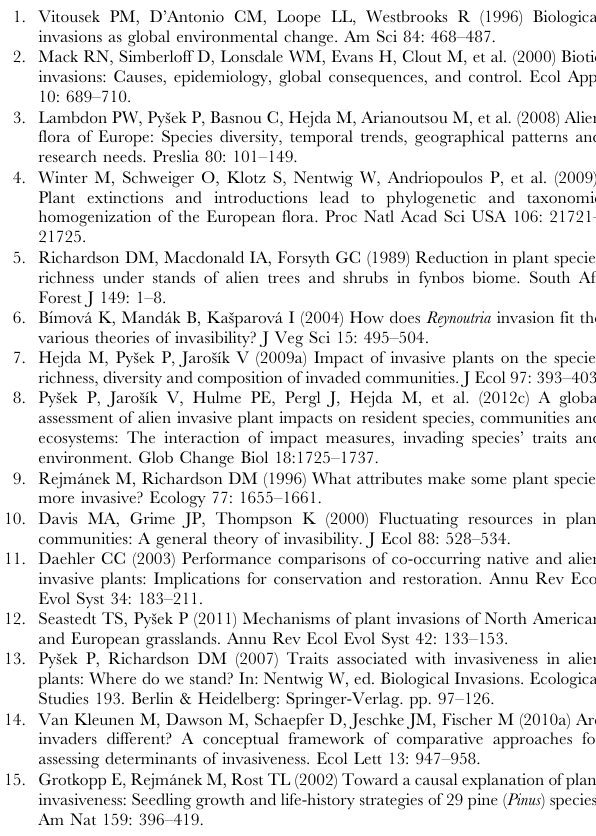
significant. In case of significant interactions between the treatments, the pattern of bars differs for each level of each treatment. Bars of mean species values whose 95% least square differences (LSD) intervals do not overlap are significantly different. In case of a parallel slope of the covariate on all species the patterns are visualised with bars of mean species values expressed for the intercepts of the slopes of the covariate with x- axis; these intercepts correspond to log one of particular biomasses. In case the slopes of the covariate for each species varied significantly, the patterns are visualised as scatterplots of the response variable on the covariate, with a different slope for each species. The panel in (A) without LSD intervals is calculated from LMM model; bars with different letters are significantly (P , 0.05) different. Figure S2 Comparisons of shoot biomass of I. capensis, I. glandulifera, I. noli-tangere and I. parviflora in the second experiment. Otherwise as in Fig. S1. Figure S3 Comparisons of branch number of I. capen- sis, I. glandulifera, I. noli-tangere and I. parviflora in the second experiment. In case that the treatments are significant but do not interact, the height of bars is different for each level of the significant treatment but the pattern of bars is the same for all species (B). In (C), both the effect of shade and soil moisture are significant, but only the interaction of the species with soil moisture is significant. Otherwise as in Fig. S1.